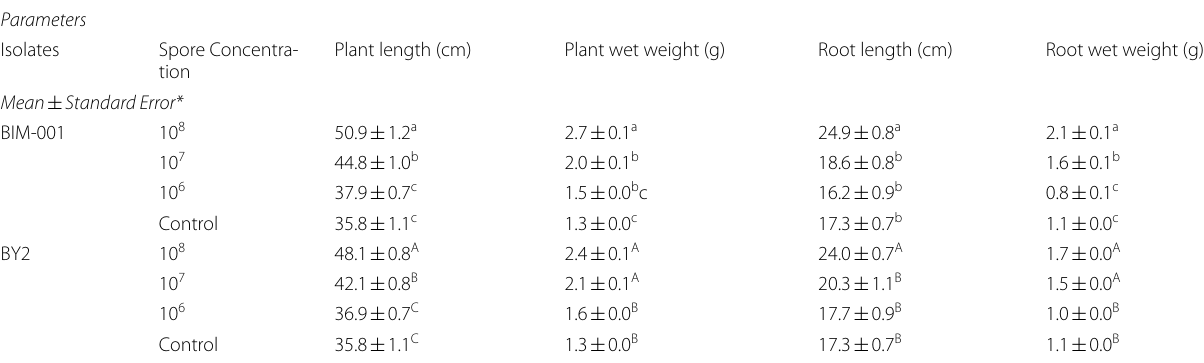
Different lowercase letters in the same column indicate significantly different means for isolate BIM-001, while uppercase letters in the same column indicate significantly different means for isolate BY2 ( P ≤